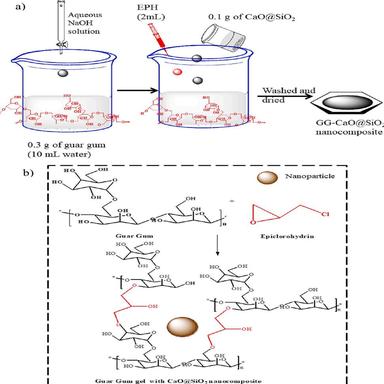
(a) Pictorial representation for the synthesis and possible mechanism of GG-CaO@SiO2 nanocomposite (b) Possible mechanism of GG-CaO@SiO2 nanocomposite.